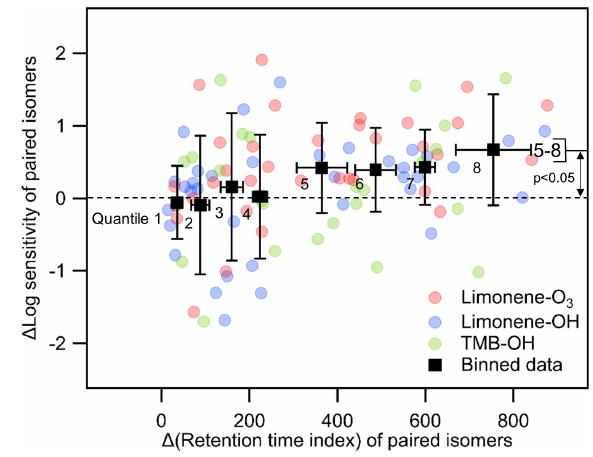
Figure 7. Relationship between sensitivities and retention time in- dex of all compounds in oxidation experiments. Black markers are all data equally divided into eight bins based on the ranking of their sensitivity and retention time index, centered on averages with error bars representing the standard deviation of sensitivity and retention time index. The size of the round marker represents the number of moles of each compound.